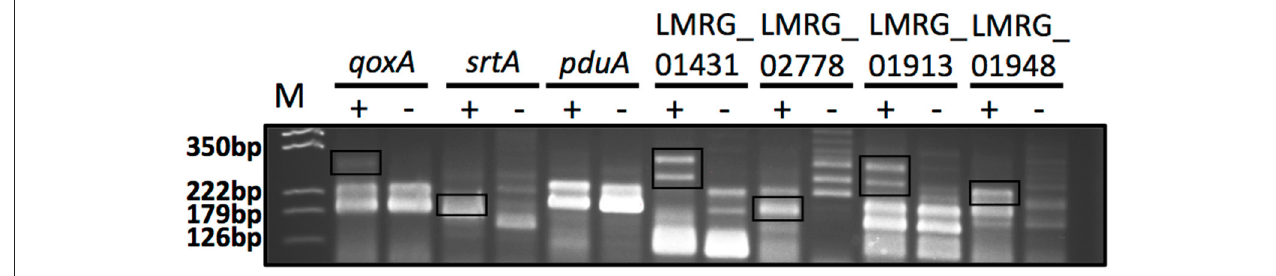
FIGURE 4 | 5 ′ RACE PCR confirmation of six putative σ B-dependent promoters newly identified here by RNA-seq. The six putative σ B -dependent promoters selected for confirmation are located upstream of qoxA , srtA , pduA, LMRG_01431, LMRG_02778, and LMRG_01913. LMRG_01948 was used as a positive control, as it was reported to have a strong σ B -dependent promoter (Abram et al., 2008b). The image shows the 5 ′ RACE PCR products in a 3% agarose gel; the two lanes for each target represent reaction performed with RNA isolated from the 1 BCHL P rha -sigB strain, which expresses σ B ( + ) and the 1 BCHL-P rha strain, which does not express σ B ( − ). The σ B -dependent transcript bands are shown in rectangles. Multiple 5 ′ RACE bands were expected for these genes as they were all initially characterized by having a putative σ B -dependent promoter as well as an additional σ A -dependent promoter. Five of six promoters selected for confirmation displayed clear σ B -dependent transcript bands, supporting the existence of σ B -dependent promoters. 5 ′ RACE PCR for pduA did not yield a band that confirmed the putative σ B -dependent promoter that was identified by RNA-seq; a putative σ A -dependent promoter was found 14 nt upstream of the putative σ B -dependent promoter; transcripts from this σ A -dependent promoter may have masked the σ B -dependent transcript. The expected sizes of the σ B -dependent transcript bands are around 250 bp for qoxA , 170 bp for srtA , 165 bp for pduA , 275 bp for LMRG_01431, 185 bp for LMRG_02778, 275 bp for LMRG_01913, and 210 bp for LMRG_01948. The image was adjusted for contrast, intensity levels and saturation using Photoshop; manipulations were performed on the whole picture and no specific bands were enhanced or modified. The results shown here are representative of three biological